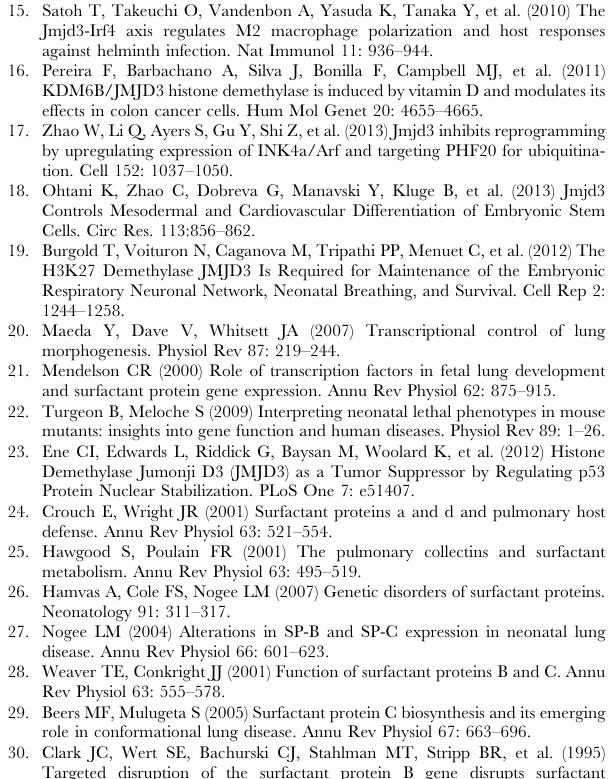
Table S1 Genotyping analysis of embryos and newborns from Jmjd3 + / 2 breeding pairs. Table S2 Microarray analysis of gene expression in Jmjd3 2 / 2 and WT embryonic lungs at E17.5. Table S3 ChIP-Seq analysis of H3K4 and H3K27 methylation around + / 2 5 kb of TSS. Table S4 ChIP-Seq analysis of H3K4 and H3K27 methylation around 2 2 kb of